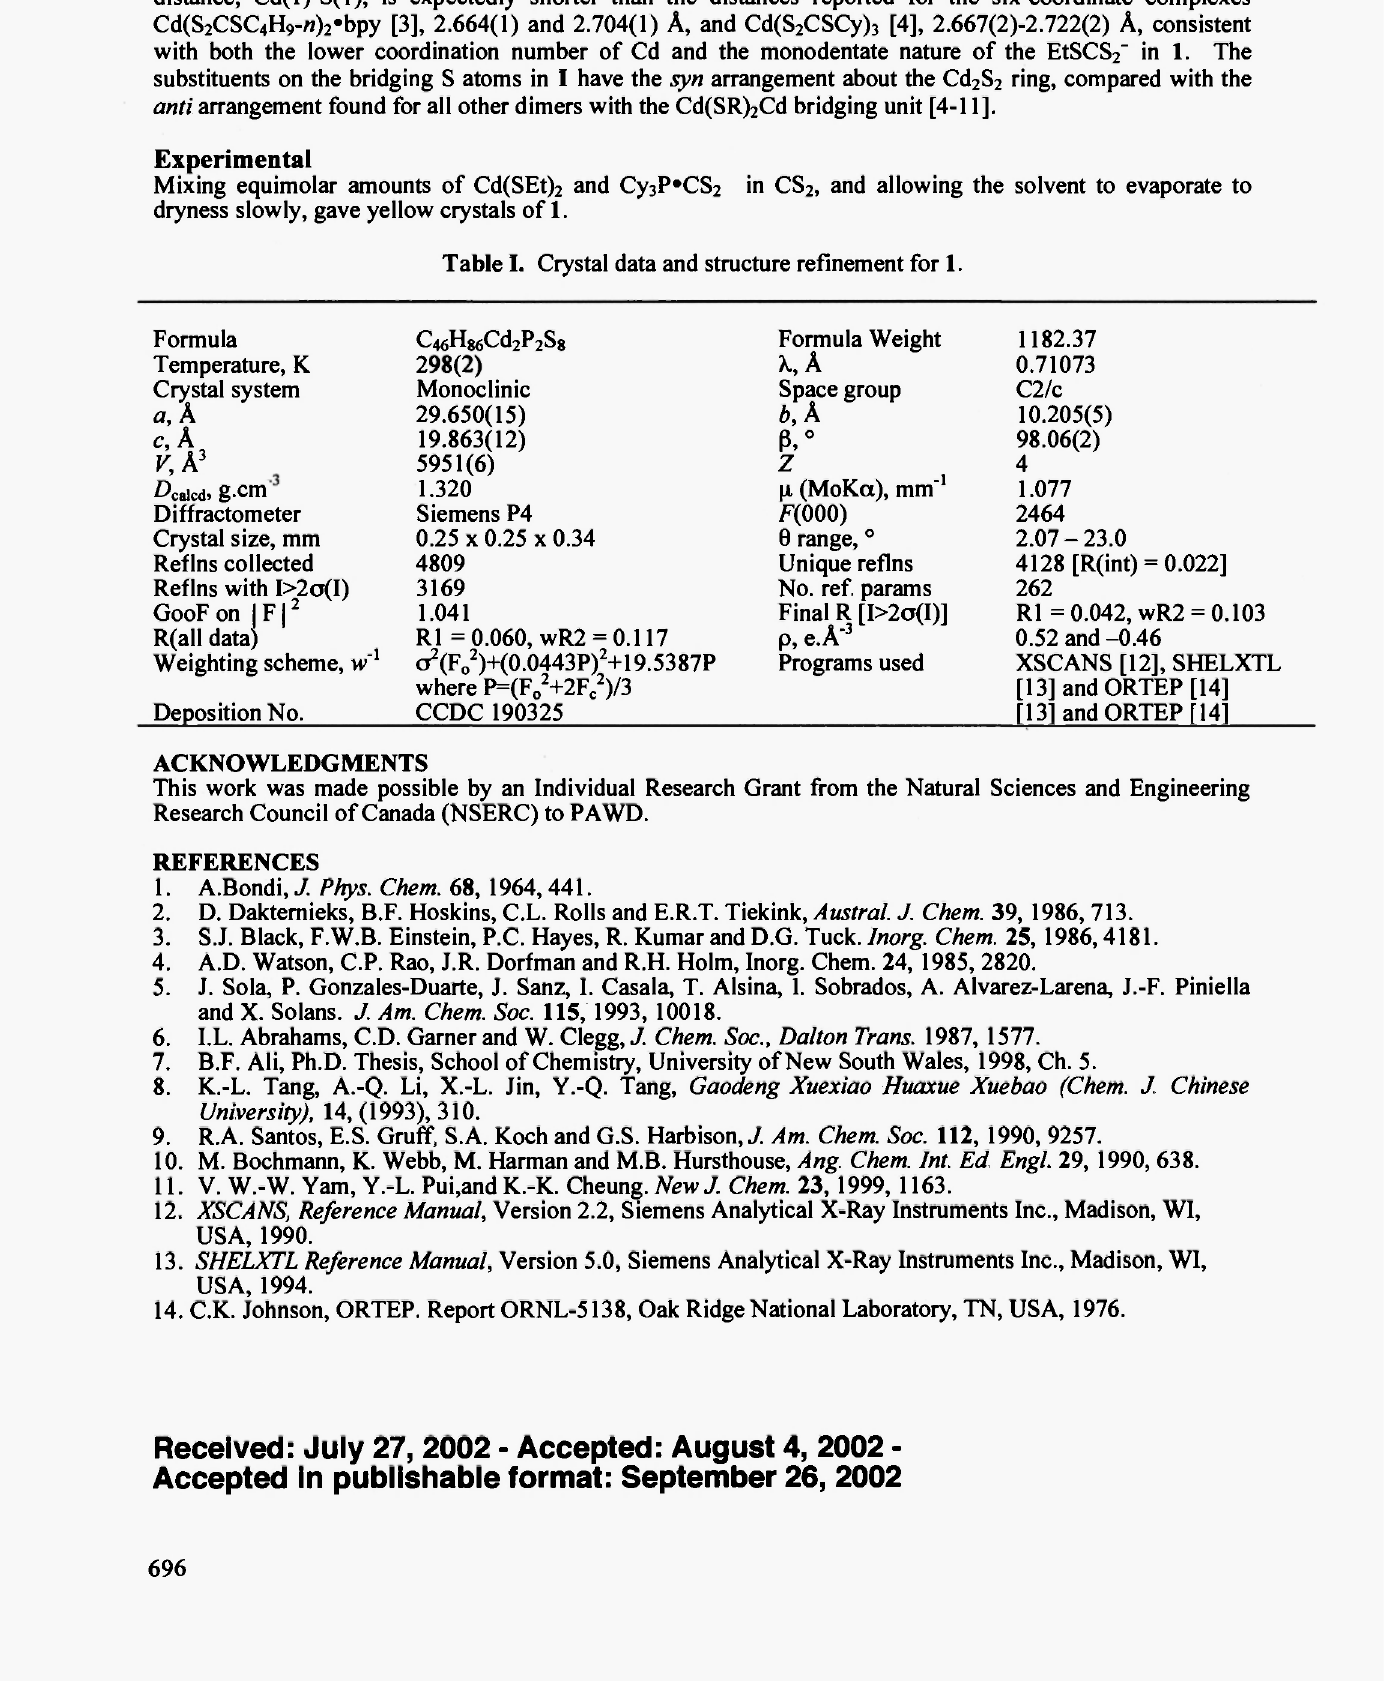
Table I. Crystal data and structure refinement for